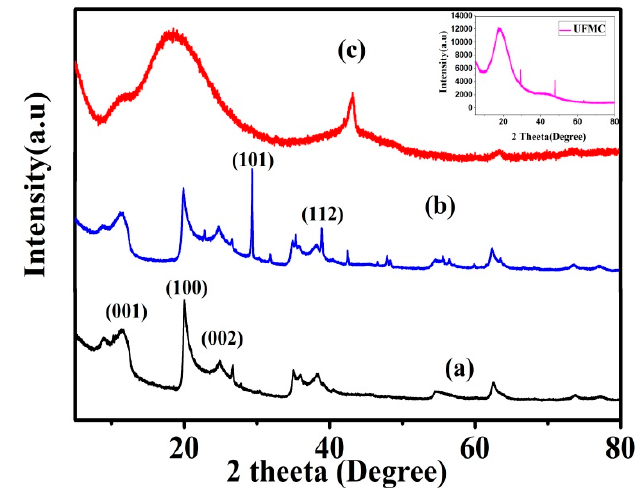
Figure 4. XRD analysis: ( a ) HNTs, ( b ) HNTs loaded with NaNO 3 , and ( c ) Nanocomposite coatings. Inset shows the XRD of UFMCs.